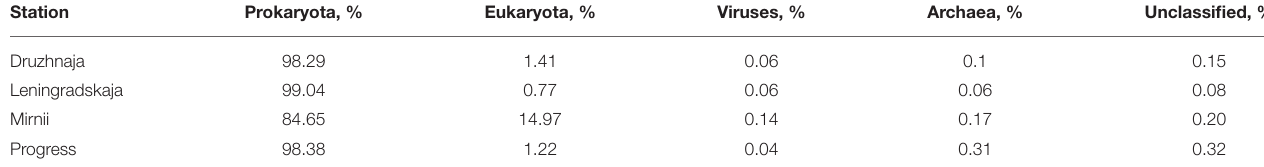
TABLE 2 | Overall phylogenetic structure of snow microbial communities. Station